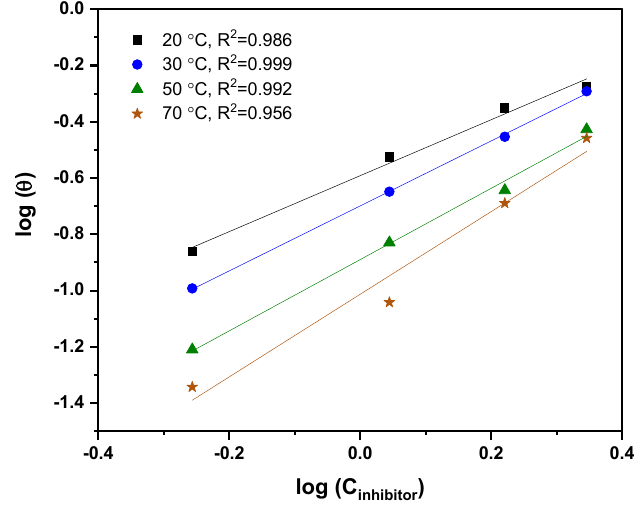
Figure 6. Freundlich isotherm fitting for the adsorption of Q-22 in 5 M HCl onto C-steel at 20, 30, 50, and 70 °C.